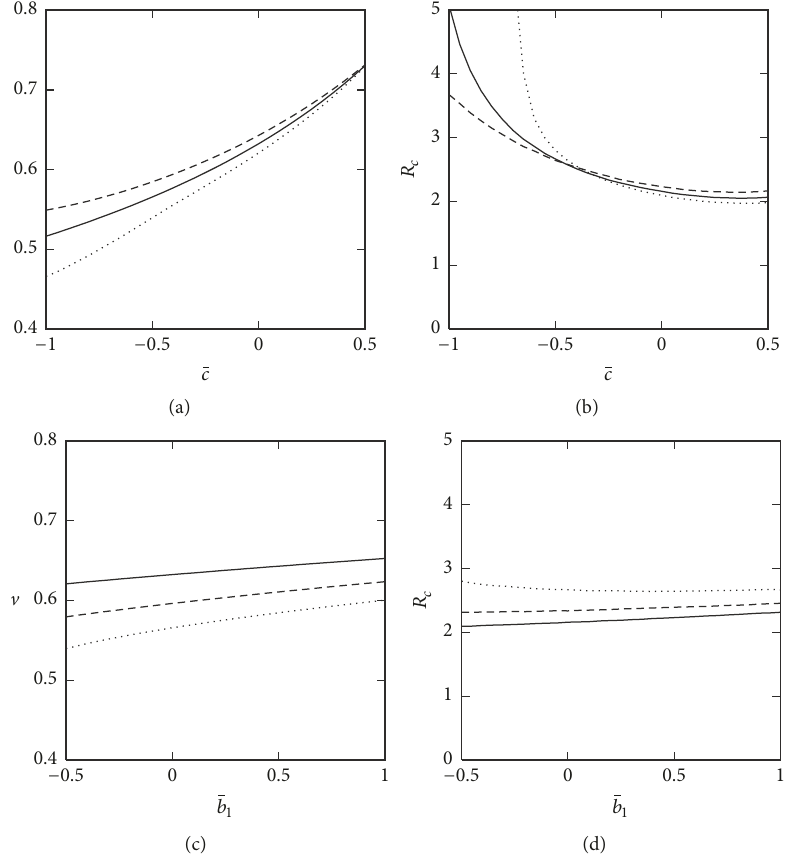
Figure 10: Dependence of velocity and radius on 𝑐 and 𝑏 1 in the stationary circular motion. Data are obtained by the simulation of the full tensor model. 𝑏 𝑠 = 0.1, 𝛾 = 0.5, and 𝜅 = 0.2 . (a) Dependence of V on 𝑐 . (b) Dependence of 𝑅 𝑐 on 𝑐 , where, in (a) and (b), the solid, dashed, and dotted curves correspond to 𝑏 1 = 0 , 0.5, and − 0.5, respectively. (c) Dependence of V on 𝑏 1 . (d) Dependence of 𝑅 𝑐 on 𝑏 1 , where, in (c) and (d), the solid, dashed, and dotted curves correspond to 𝑐 = 0 , − 0.25, and − 0.5, respectively.